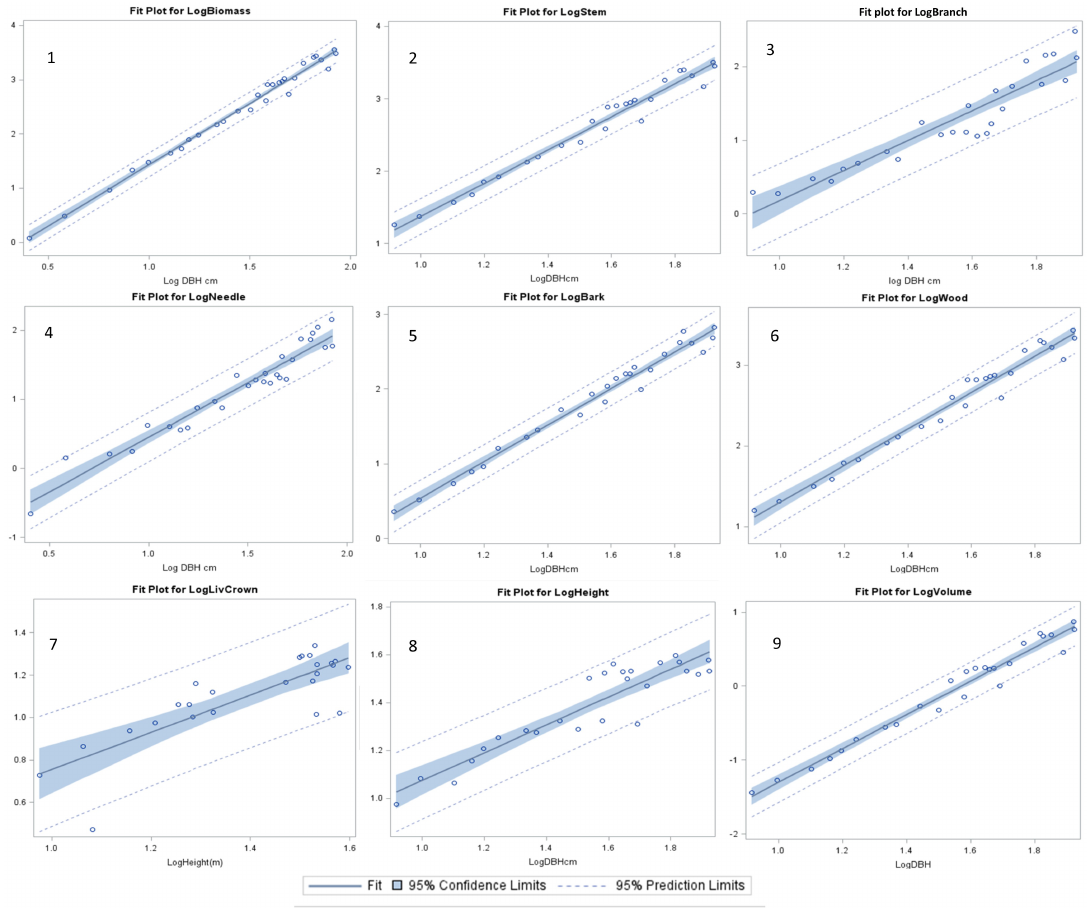
Figure 2. The logarithmic regression transformation for selected tree components for coast redwood ( Sequoia sempervirens ), including ( 1 ) total aboveground biomass; ( 2 ) bole; ( 3 ) live branch; ( 4 ) foliage; ( 5 ) bark and tree dimensions; ( 6 ) weight of wood; ( 7 ) height to live crown; ( 8 ) height of tree; and ( 9 ) volume of bole. All models were significant ( p <